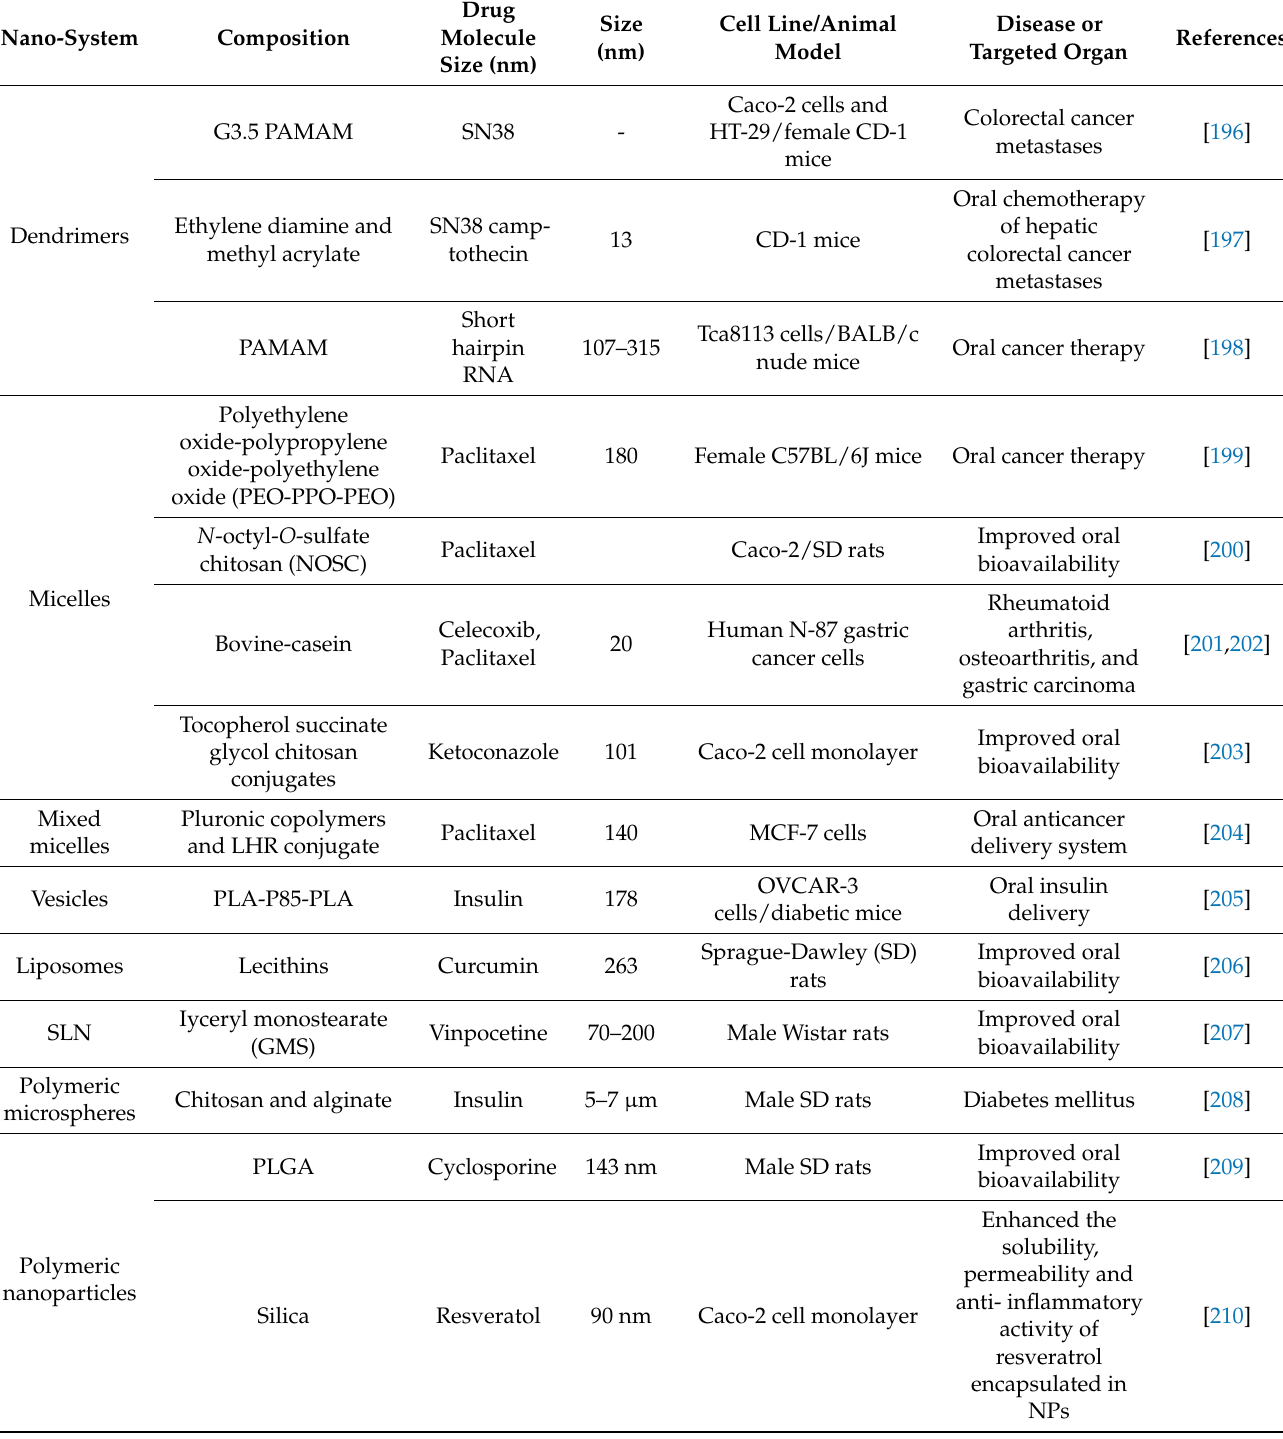
Table 10. List of nanocarrier applications in oral drug